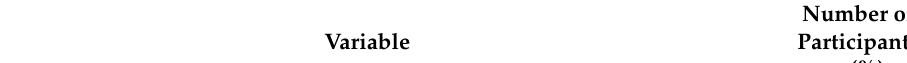
Table 3. Participants’ perceptions and self-confidence toward pharmacogenetics, its implications, and